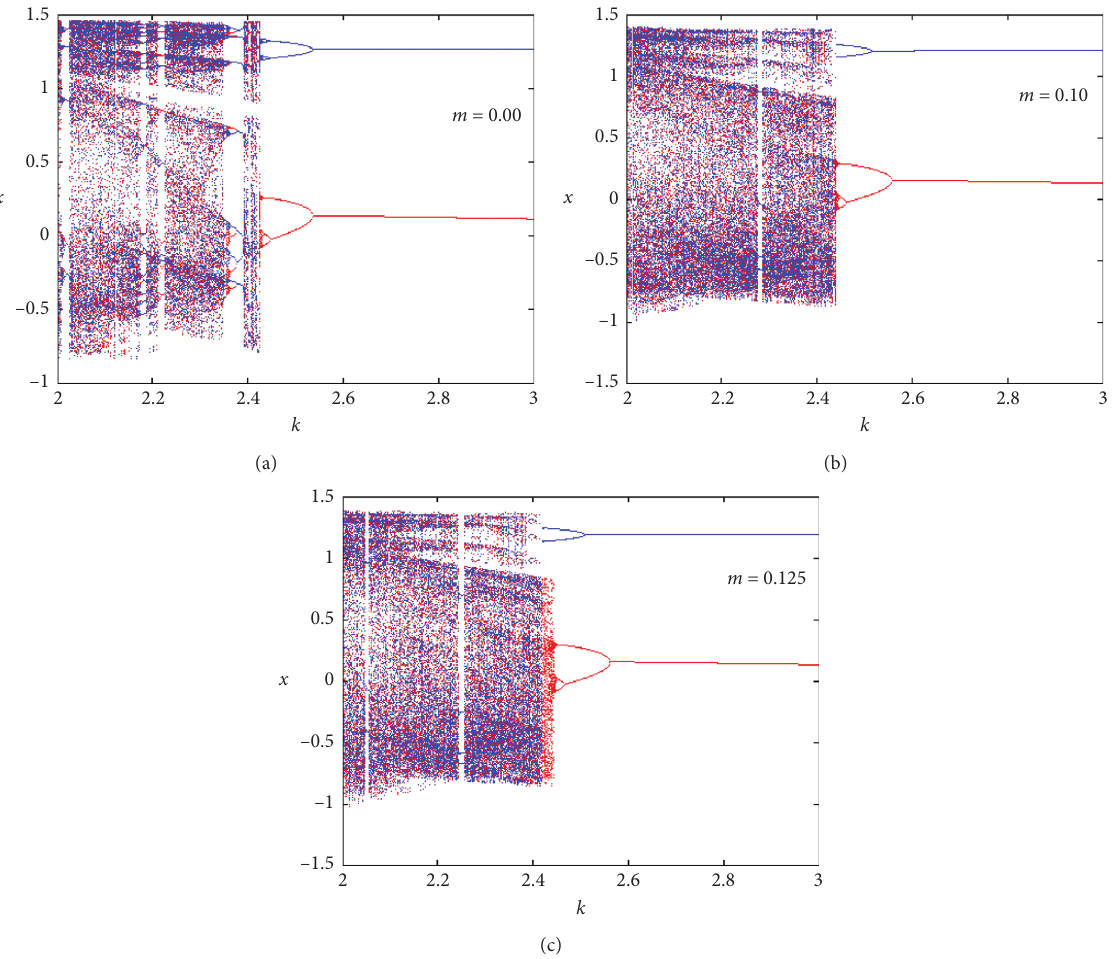
Figure 7: Bifurcation diagrams as function of the parameter k , showing destruction of the symmetry of the system for some values of m : (a) the symmetric system for m � 0; (b, c) destruction of the system symmetry for m � 0.10 and m � 0 . 125, respectively. The initial conditions are ( x ( 0 ) , y ( 0 ) ,z ( 0 )) � ( 0 . 75 , 0 , 0 ) and (− 0 . 75 , 0 , 0 ) for the traces in blue and red,